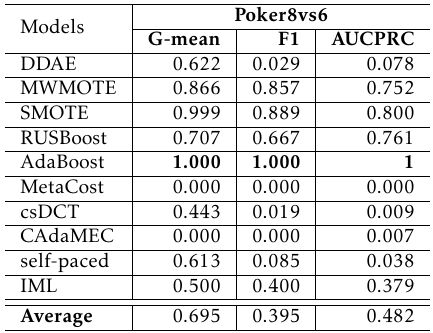
Table 16. Overall Results for Poker8vs6 Dataset